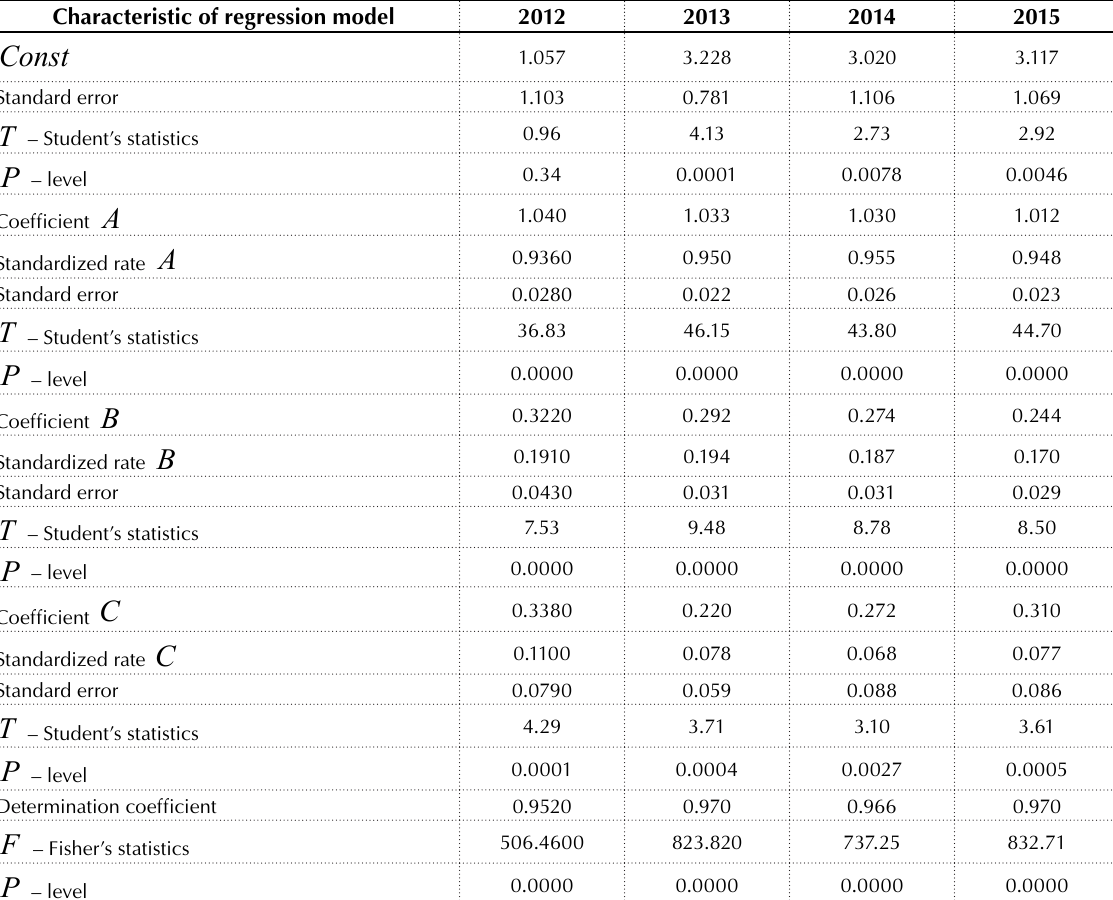
Table 1. Correlation between logarithms of gross money income, average annual number of people engaged in economy, capital-labor ratio and average level of education of human capital assets of different regions of